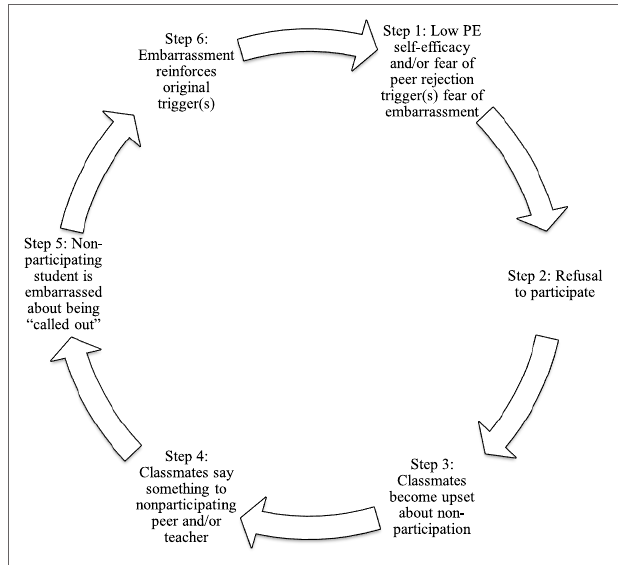
FigUre 1 | Behavioral pattern among overweight students in the physical education